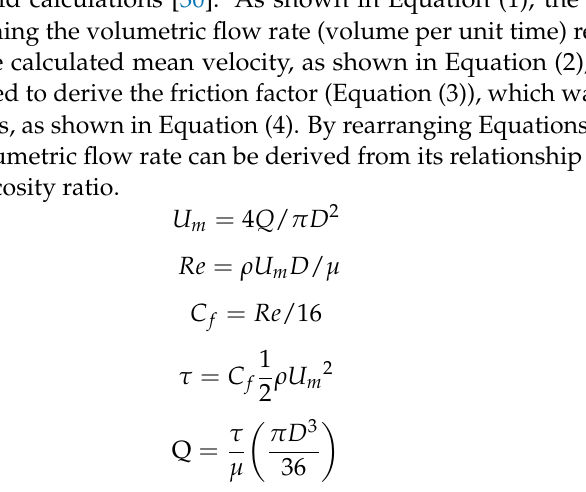
Figure 14. Measured weight of pumped mortar and weight calculated from layer